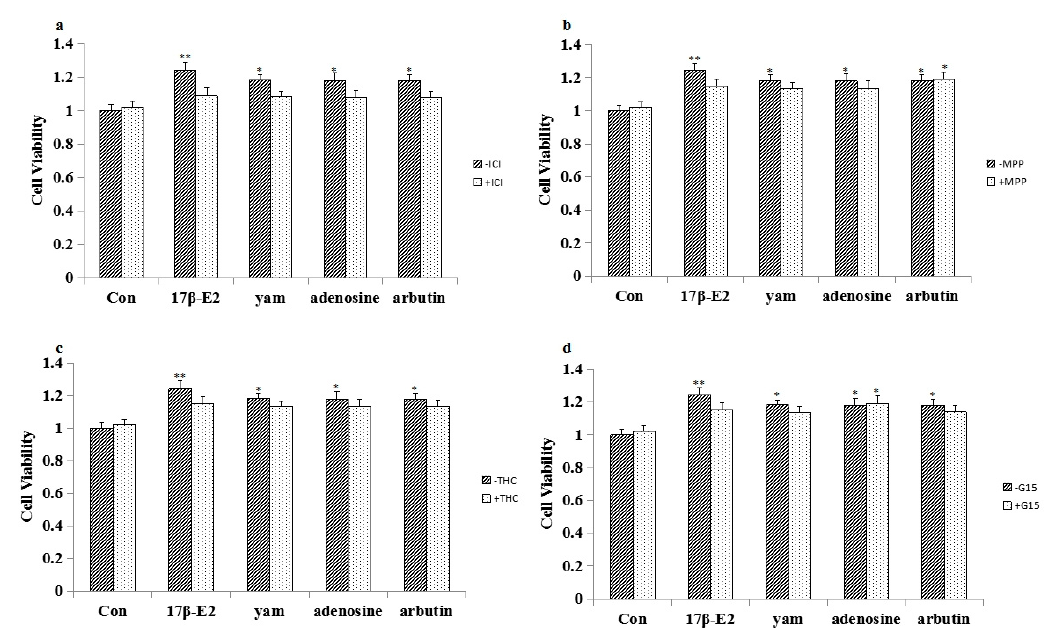
Figure 4. Effect of ICI 182780, MPP, THC and G-15 on MCF-7 cell proliferation ( n = 3). ( a ) Effects of ICI182,780 on the proliferation of adenosine- and arbutin-stimulated MCF-7 cells. ( b ) Effects of MPP on the proliferation of adenosine- and arbutin-stimulated MCF-7 cells. ( c ) Effects of THC on the proliferation of adenosine- and arbutin-stimulated MCF-7 cells. ( d ) Effects of G-15 on the proliferation of adenosine- and arbutin-stimulated MCF-7 cells. * p < 0.05; ** p < 0.01 compared to the control group.